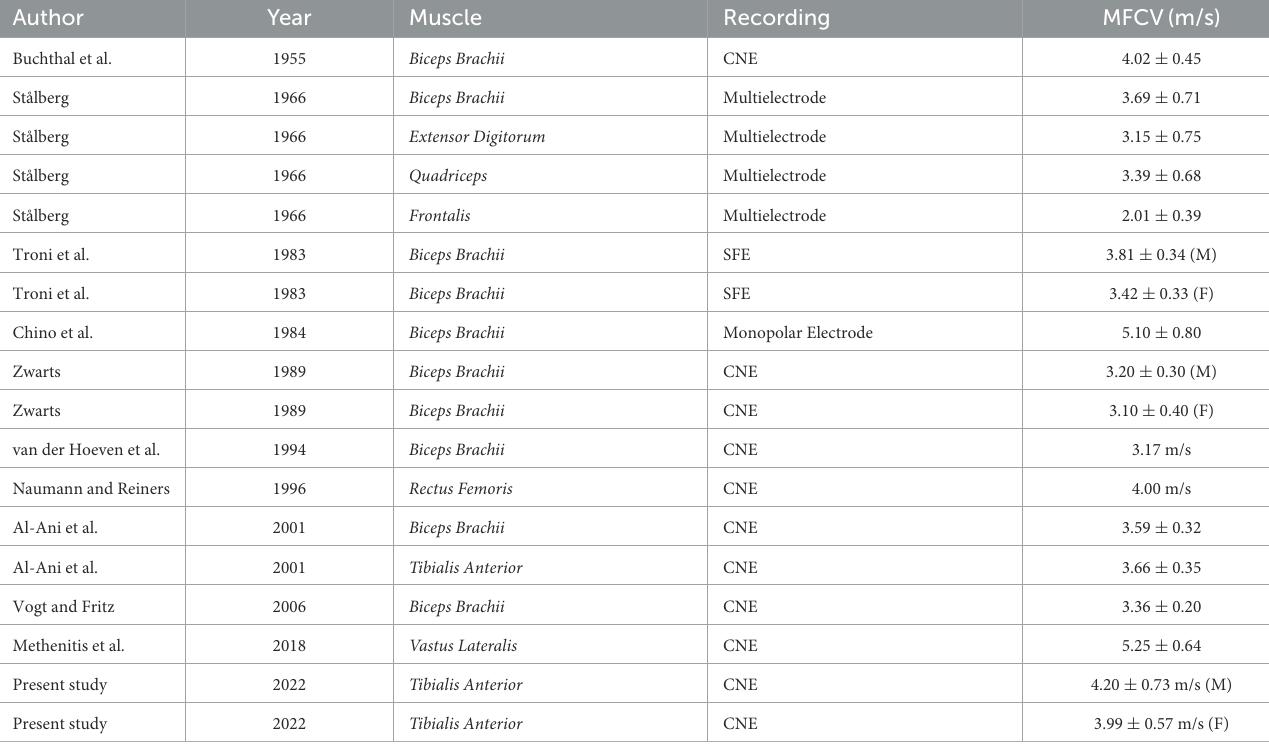
TABLE 4 Summary of the main reports on muscle fiber conduction velocity in situ .